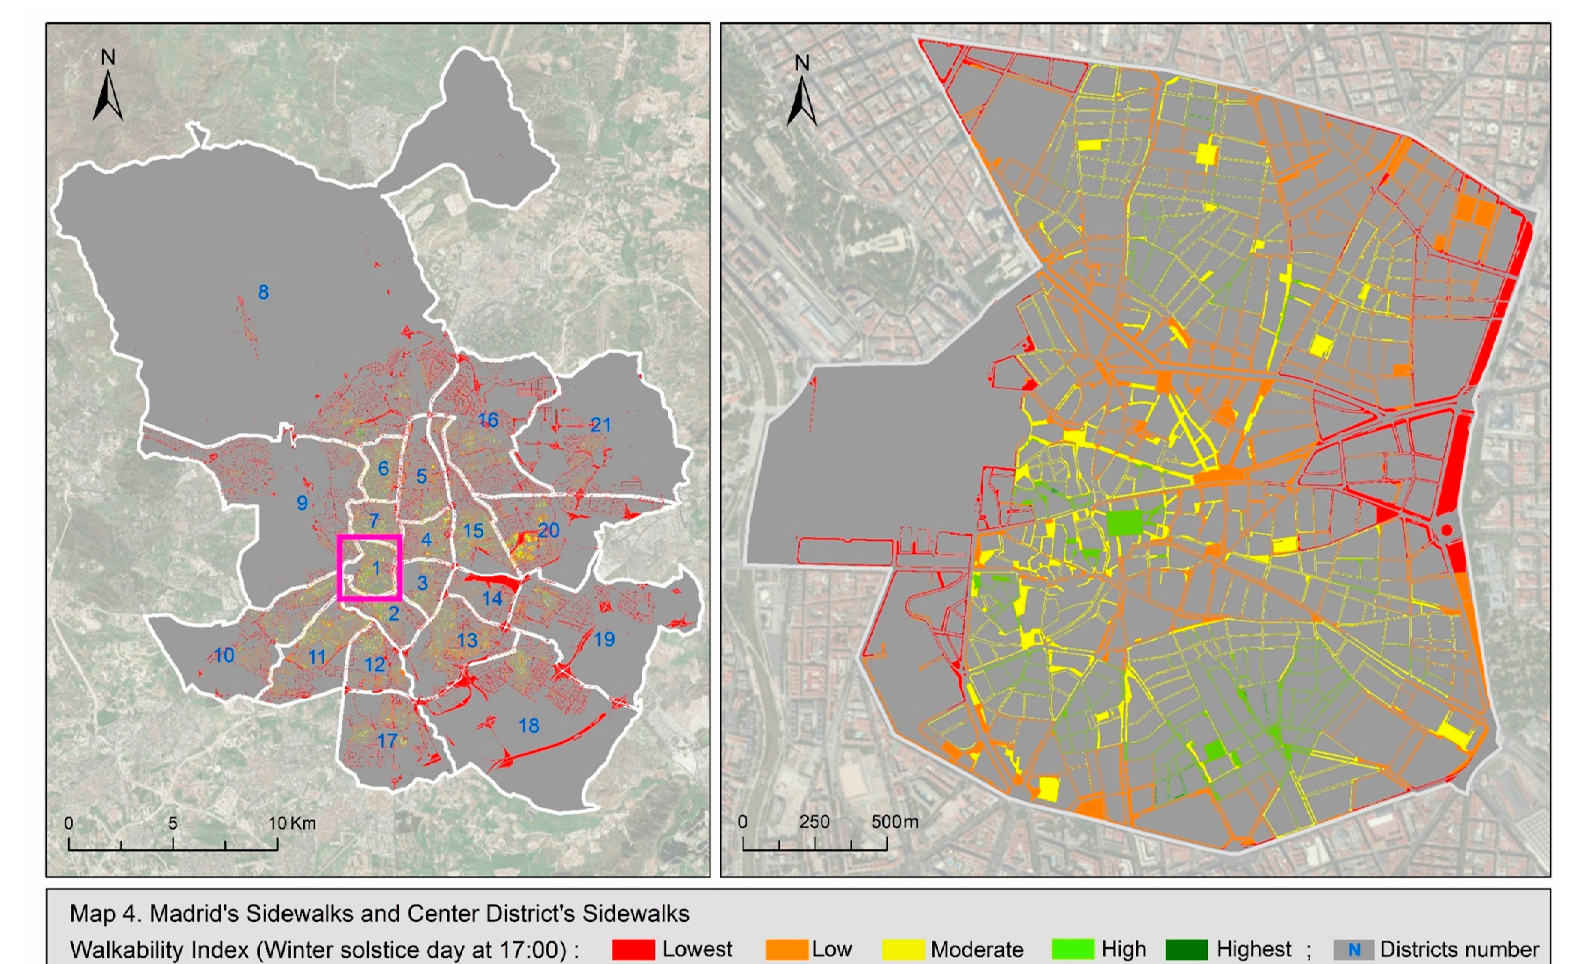
Figure A5. Walkability index results in the entire city and in the central district (detail) at 5 pm on winter